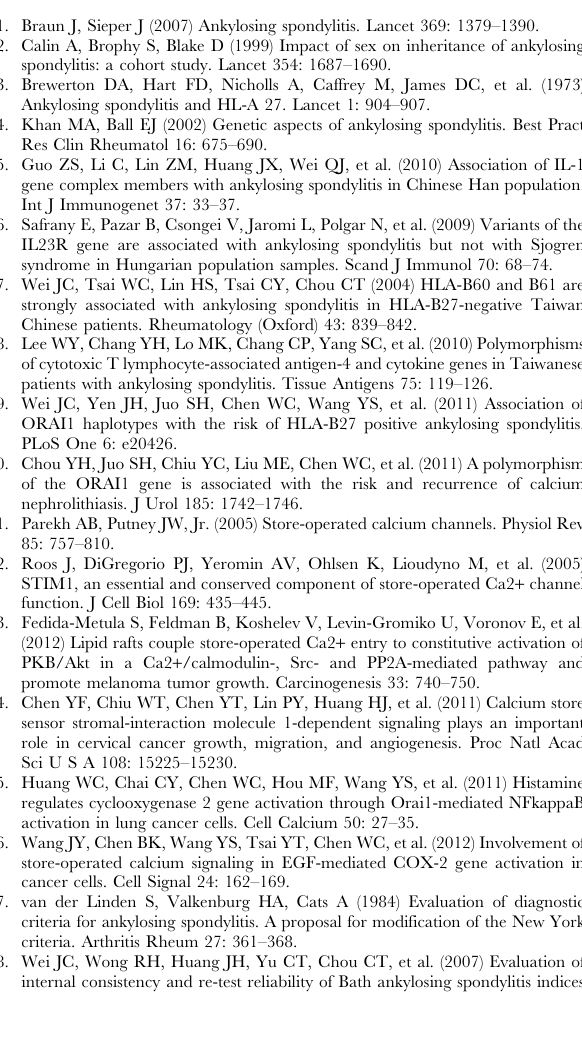
Figure S1 Knockdown STIM1 gene reduced Thapsigar- gin-mediated TNF- a gene expression in THP-1